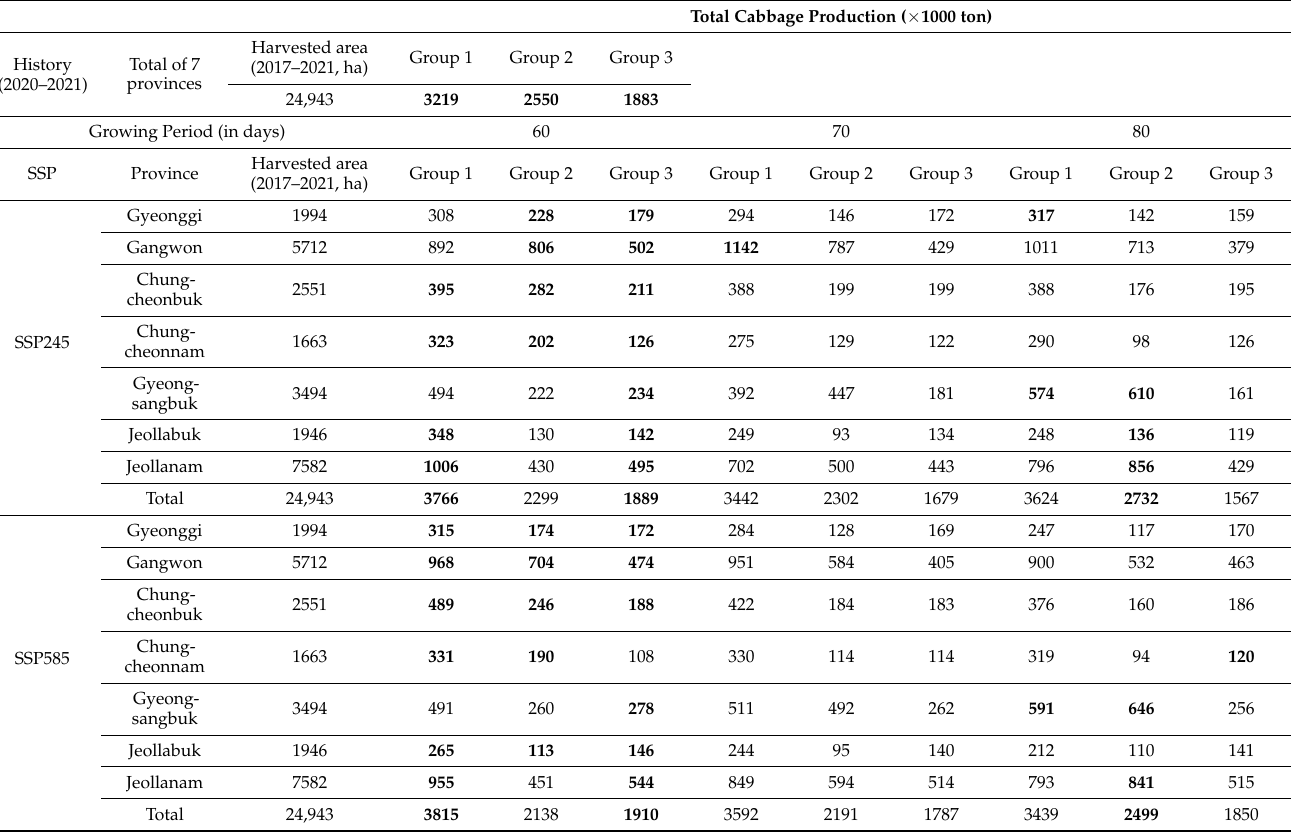
Table 6. Simulated total Chinese cabbage production (ton) in seven provinces in South Korea under two climate change pathways (SSP245 and SSP 585). Measured total production in 2020–2021 averaged over all seven provinces used in this study. Numbers in bold indicate the highest production among the three growing periods within the group and location.